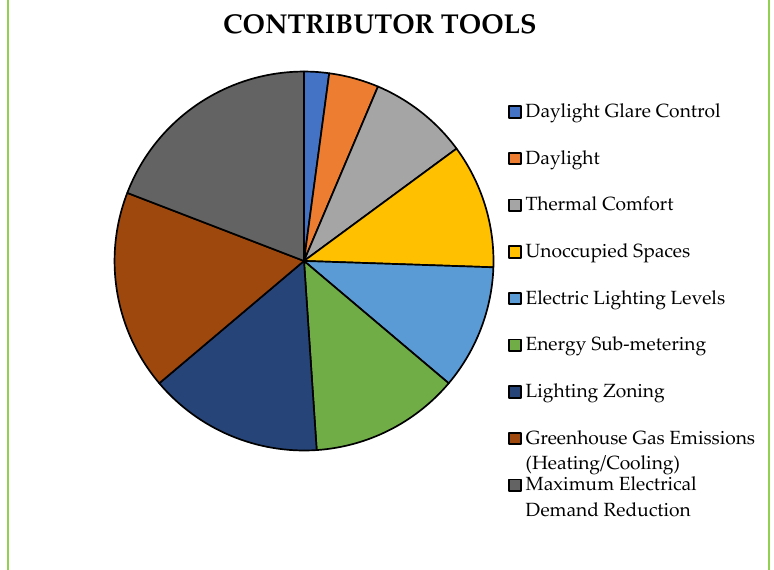
Figure 10. Ranking of design cost contributor tools.